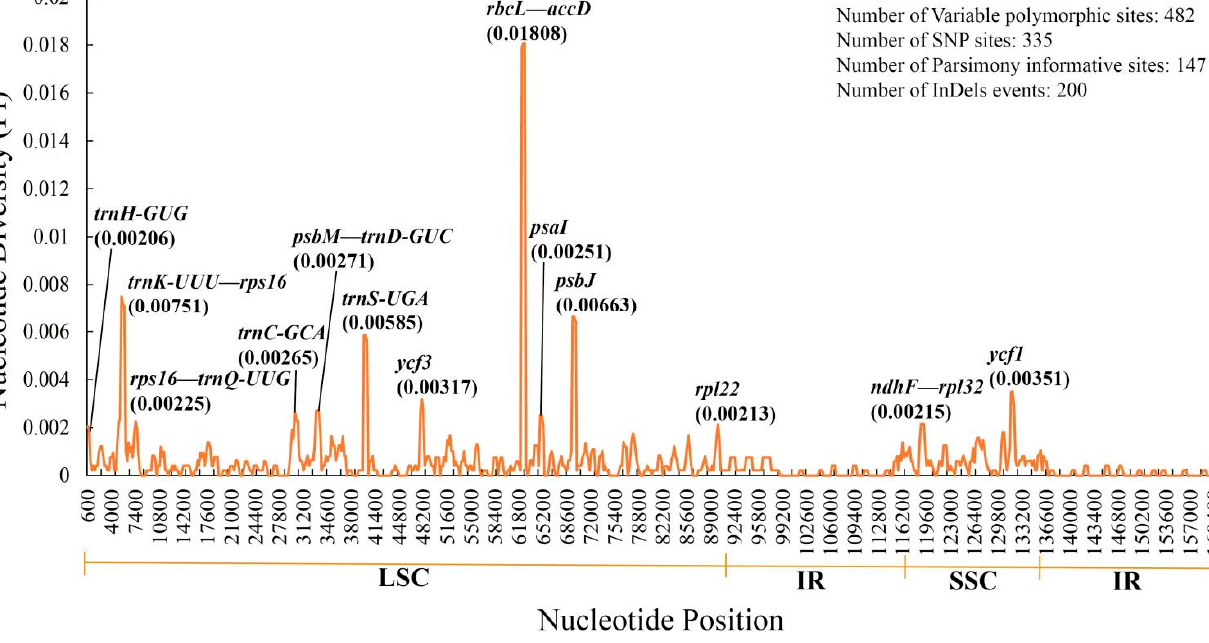
Figure 3. Sliding window analysis of 16 chloroplast genomes of Quercus section Cyclobalanopsis . The x -axis represents the site positions of the middle point of the window, and the y -axis represents the value of nucleotide diversity (Pi) per window.